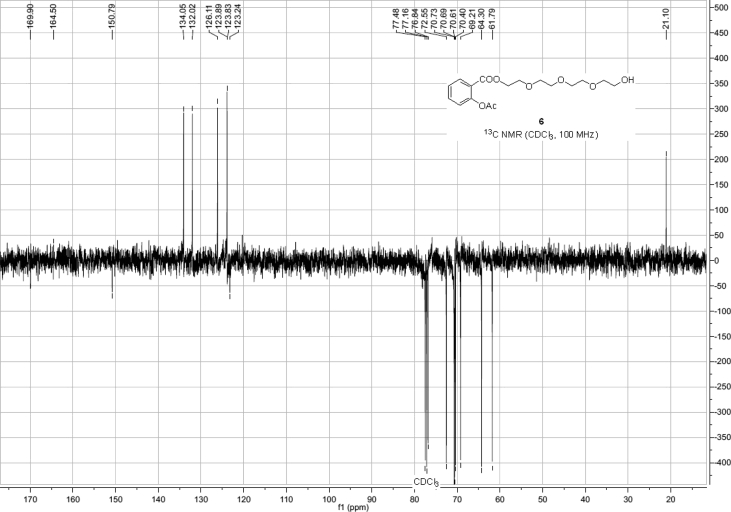
13C NMR spectra of compound 6.